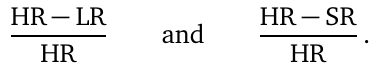
Figure 6: Distribution of the number of active pixels and high-level observables m τ /τ /τ , τ , w , and for images down-scaled by factors 2, 4, and 8. Results are 2 1 3 2 pf shown for QCD jets (top rows) and top-quark jets (bottom